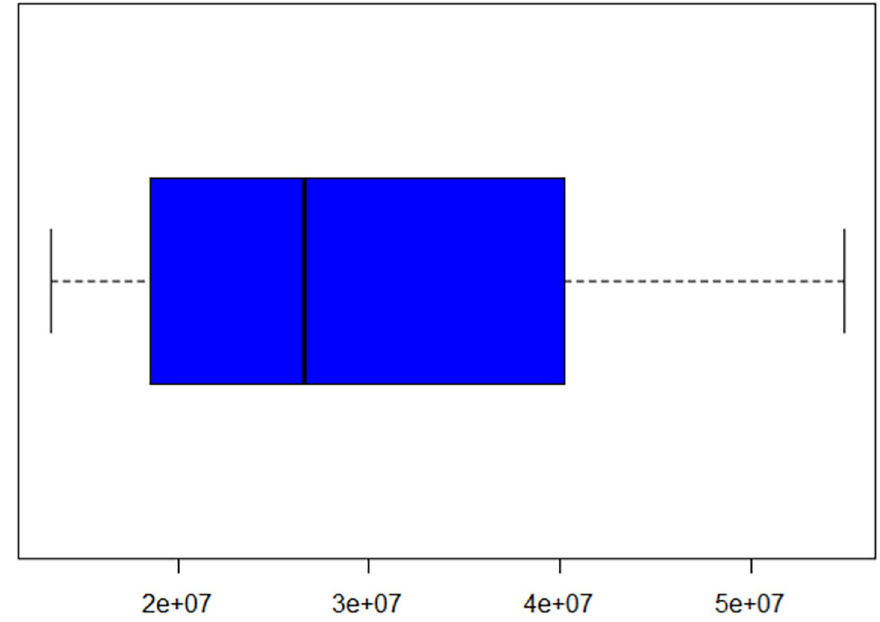
Fig 2. Boxplot of the annual rice production data in Bangladesh from 1961 to 2020.